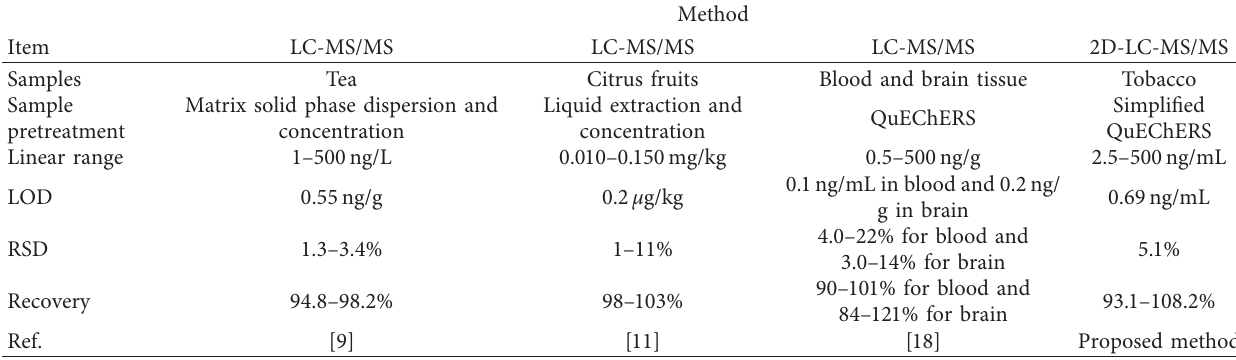
Table 4: Comparison of the proposed method with other developed methods for the determination of